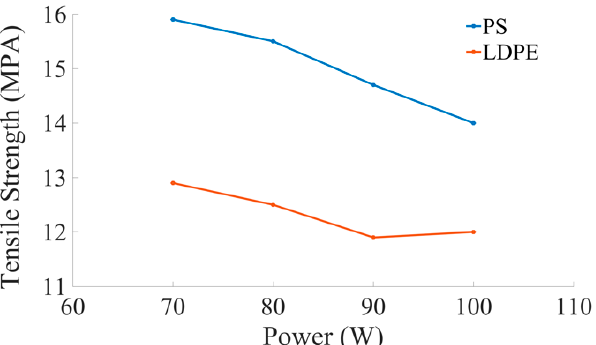
Figure 15. Parametric trend to indicate the effect of the power on tensile strength break for PS and LDPE [52].